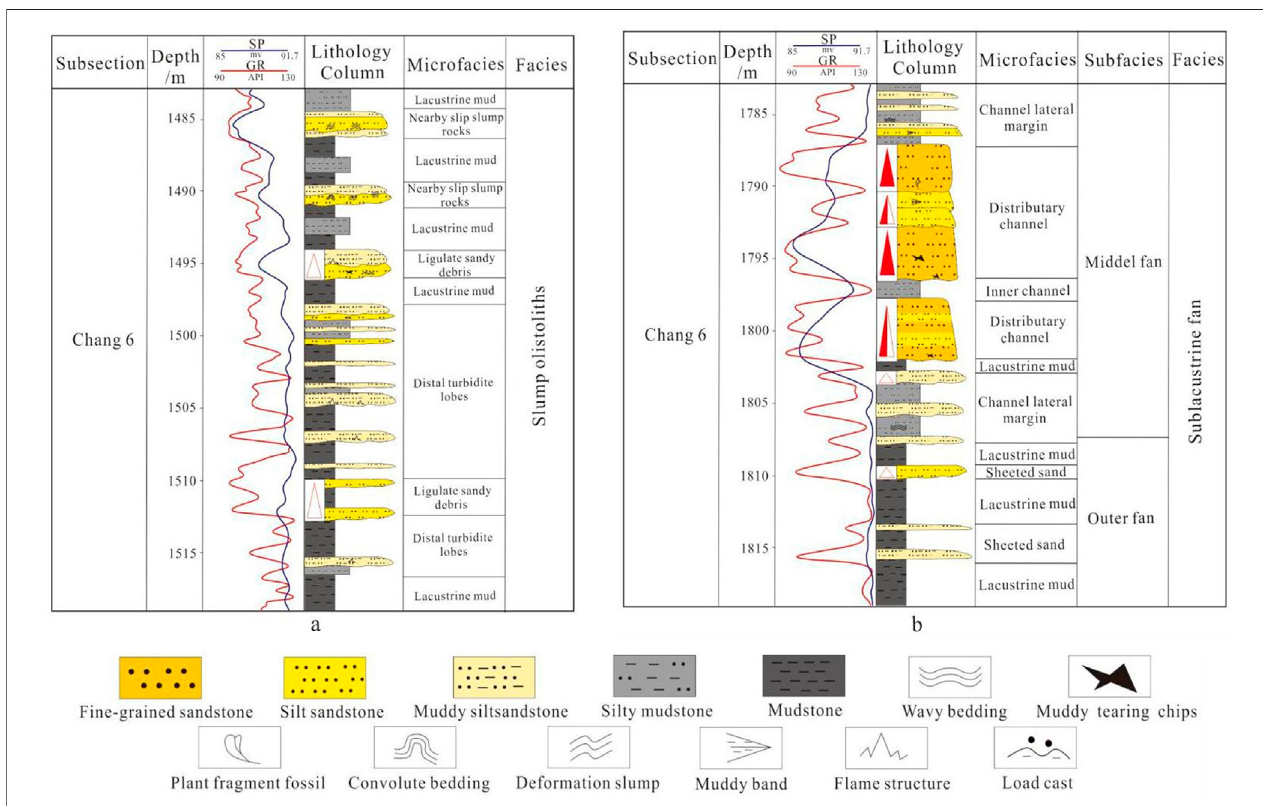
FIGURE 9 | Comprehensive map of lithology and depositional facies. See Figure 2 for the location of wells. (A) Comprehensive map of lithology and depositional facies of well ban 29, slump olistoliths model. (B) Comprehensive map of lithology and depositional facies of well Zhuang 42, sublacustrine model.